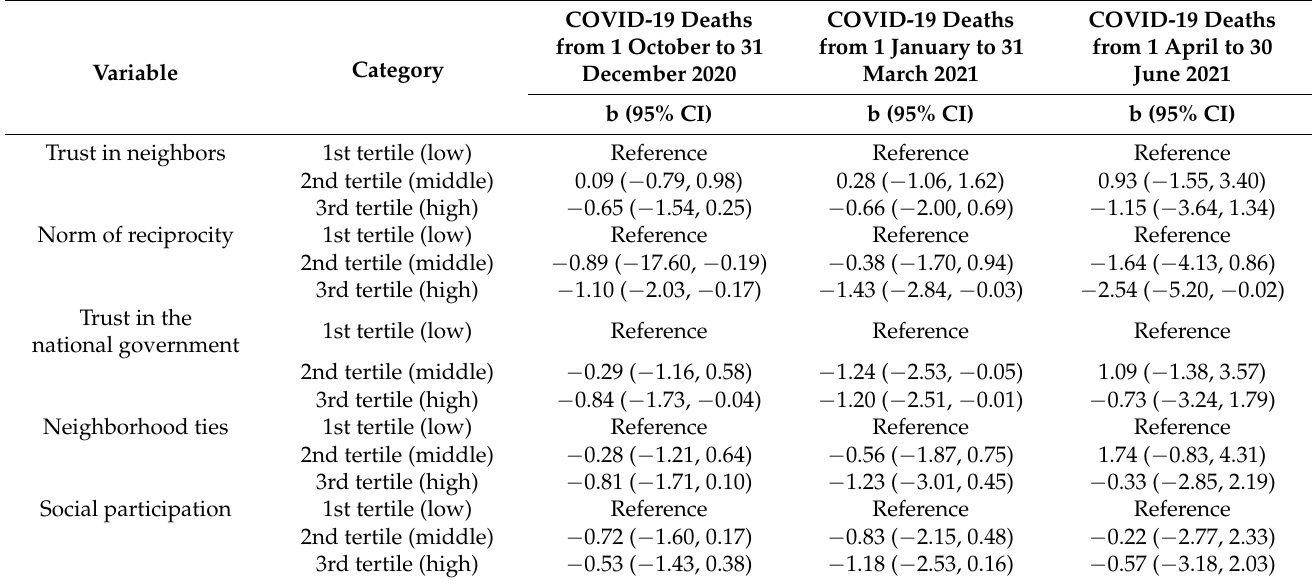
Table 3. Association between social capital and COVID-19 deaths by time